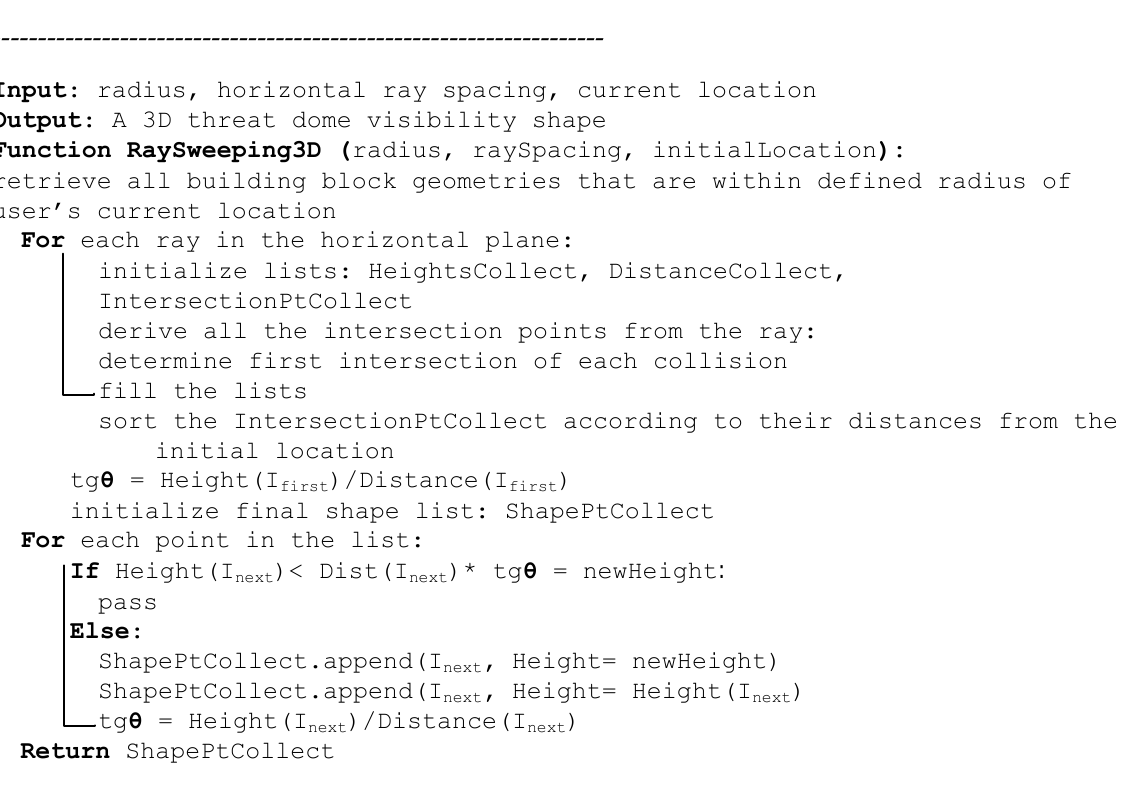
Algorithm 2: Reverse Water-Flow